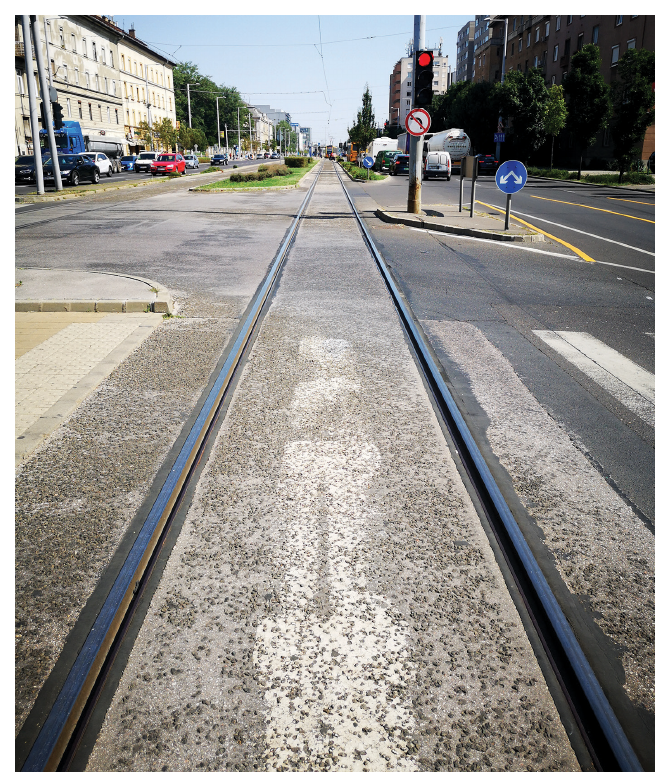
Figure 11. Section 2, 2021 (authors’